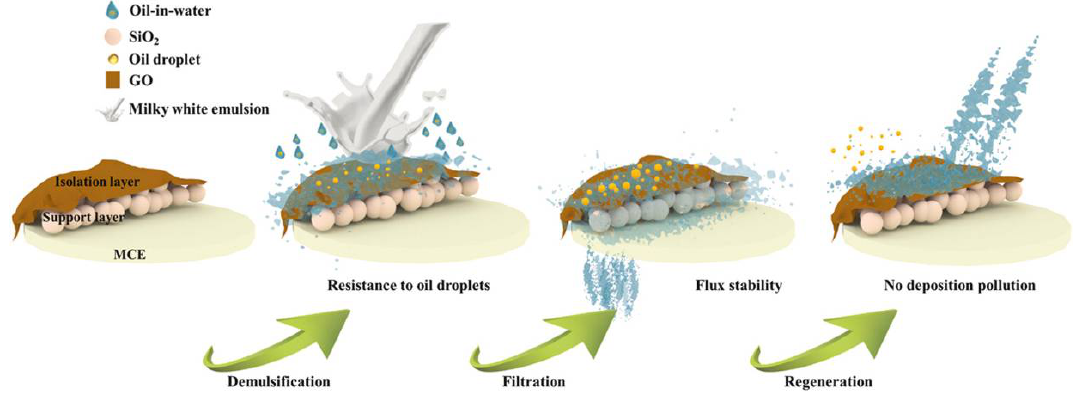
Figure 18. Concept of membrane surface construction to mitigate oily wastewater problem, using SiO 2 as the support layer and GO as the isolation layer [111].